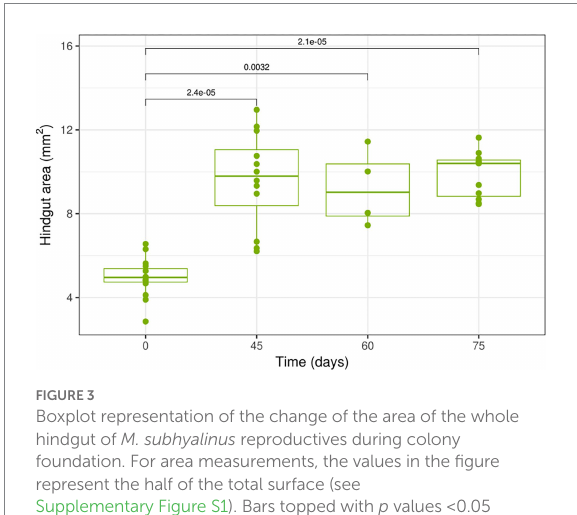
FIGURE 3 Boxplot representation of the change of the area of the whole hindgut of M. subhyalinus reproductives during colony foundation. For area measurements, the values in the figure represent the half of the total surface (see Supplementary Figure S1). Bars topped with p values <0.05 connect time points with statistically different